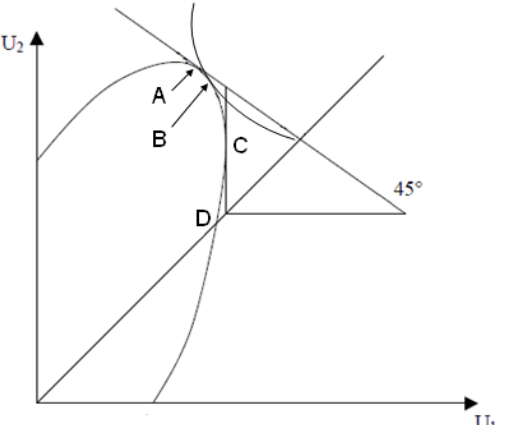
Figure 1: Utilities and function of social